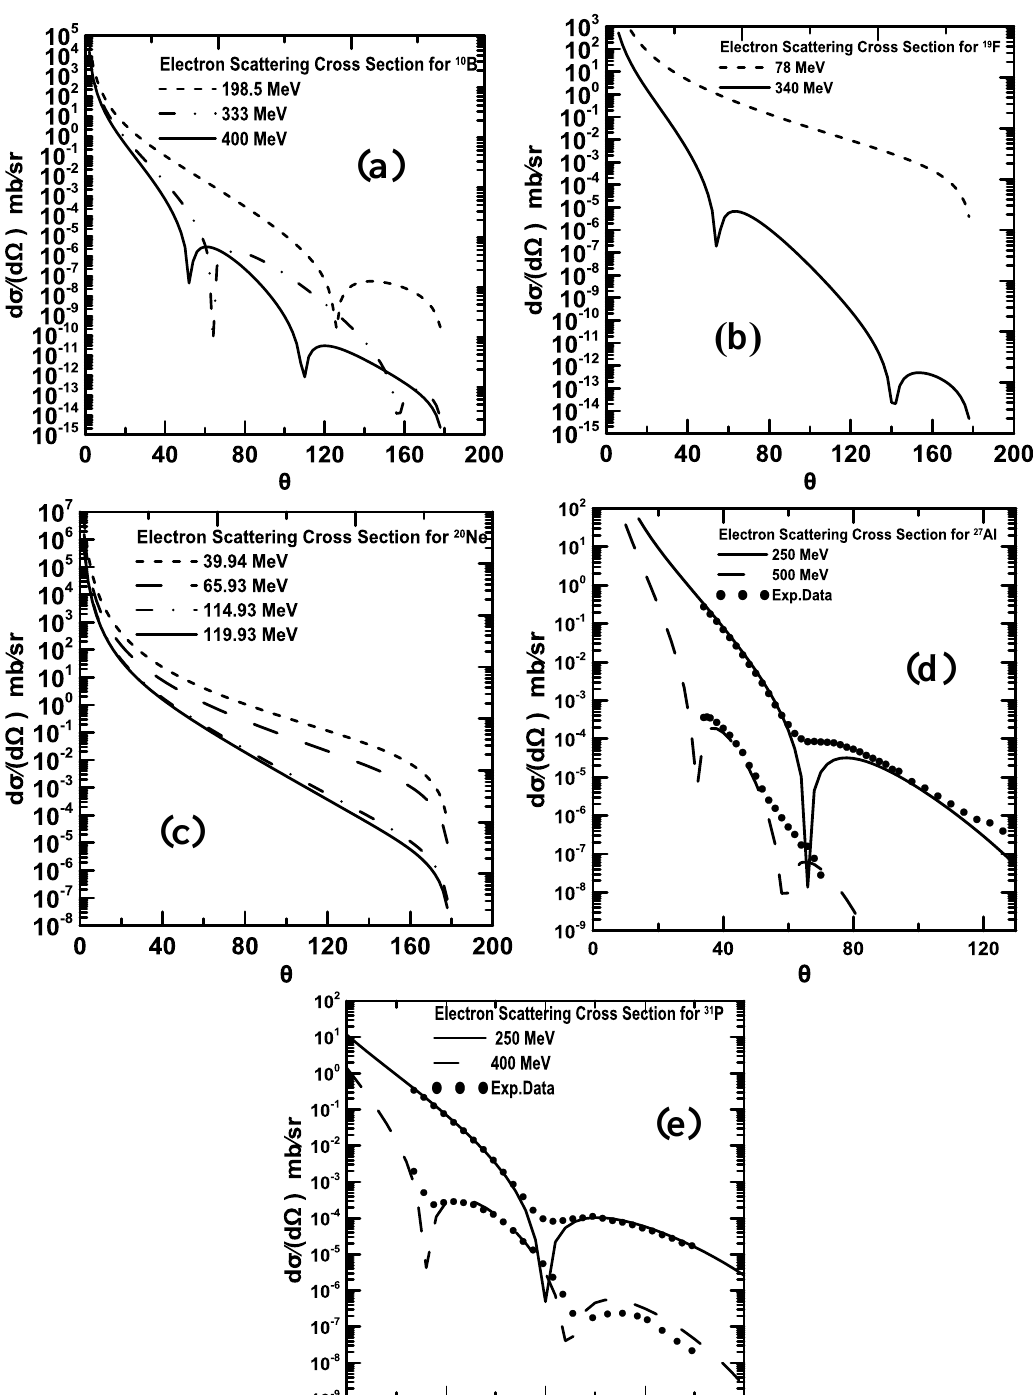
Fig. 2: Calculated electron scattering cross sections for 10 B (a) [23], 19 F (b) [24], 20 Ne (c) [25], 27 Al (d) [26] and 31 P (e) [27], respectively. The experimental data are presented by circles for 27 Al (d) and 31 P